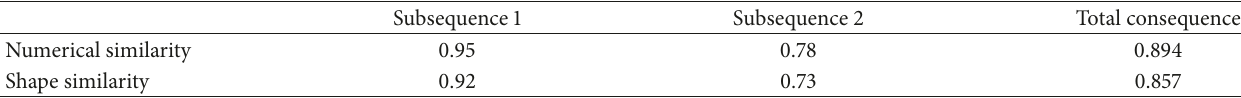
Table 2: Similarity of shock wave